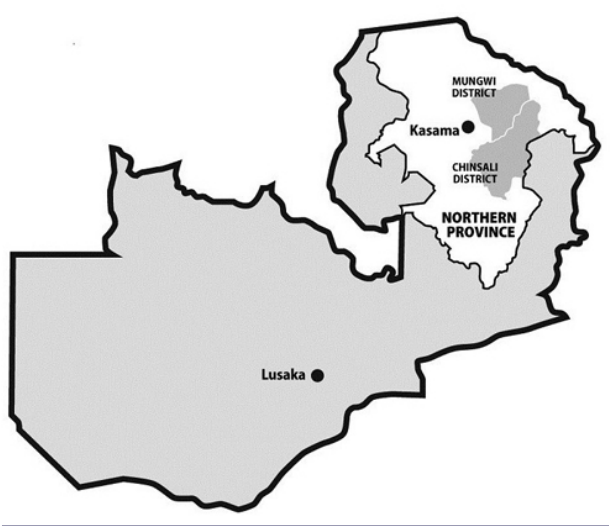
Fig. 1 . Map of Zambia with the location of the two study districts and the provincial